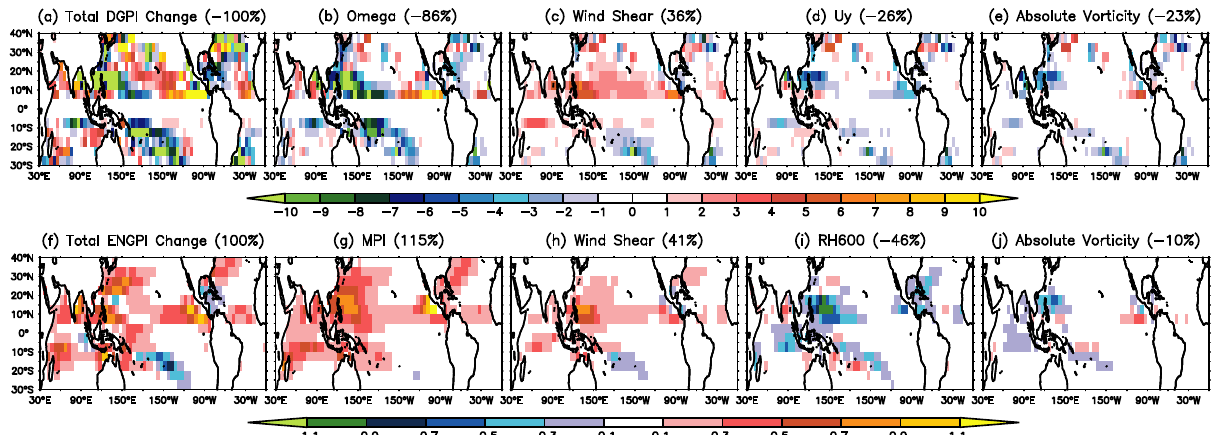
Fig. 4 Fractional contribution of each factor to the future changes in the total GPI. The fractional contribution was determined using the output from MRI-AGCM under the RCP8.5 scenario. a Total changes in DGPI, and the contribution to the total DGPI change from each factor: b 500-hPa vertical motion, c vertical wind shear, d 500-hPa shear vorticity of zonal wind, U y , and e 850-hPa absolute vorticity. f – j As in a – e but for ENGPI. Each term ’ s contribution to the total ENGPI change is shown for g MPI, h vertical wind shear, i RH 600 , and j 850-hPa absolute vorticity. The numbers in brackets indicate the fractional contribution by each factor to the total GPI changes. Because the global-total GPI change is negative for DGPI ( a – e ), the sign of the total GPI change is reversed (i.e., − 100%).